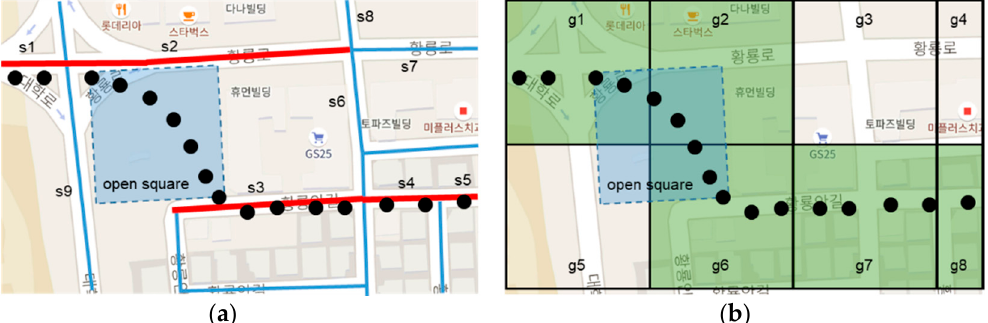
Figure 11. Result of path identification for trajectory passing through open square in ( a ) the NC-SRS and ( b ) the SRS-PIS.